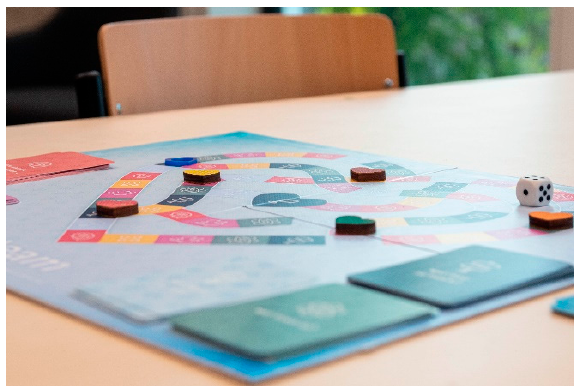
Figure 3. Board game to stimulate and facilitate conversation among team members regarding intimacy and sexuality in the nursing home.